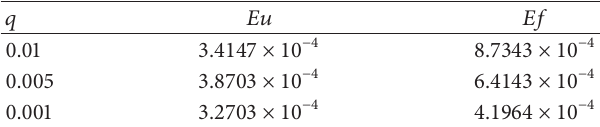
Figure 4: The exact solution 𝑓(𝑡) and the numerical solution of